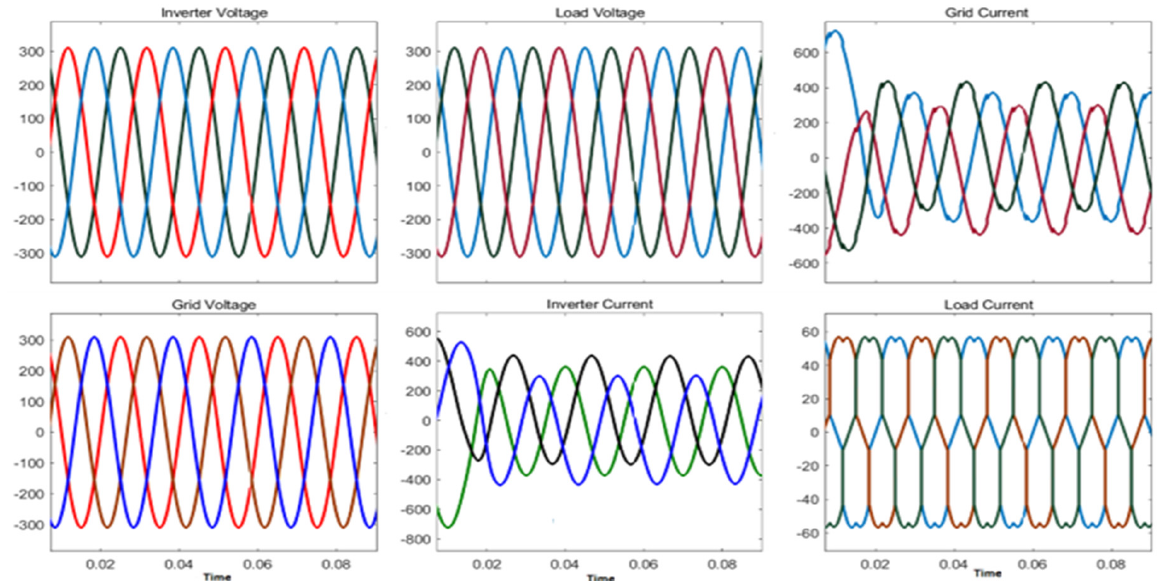
Figure 9. Voltage and current performance of the solar PV system under nonlinear load (P = 10 kW and Q = 100 VAR) and variation solar radiation.